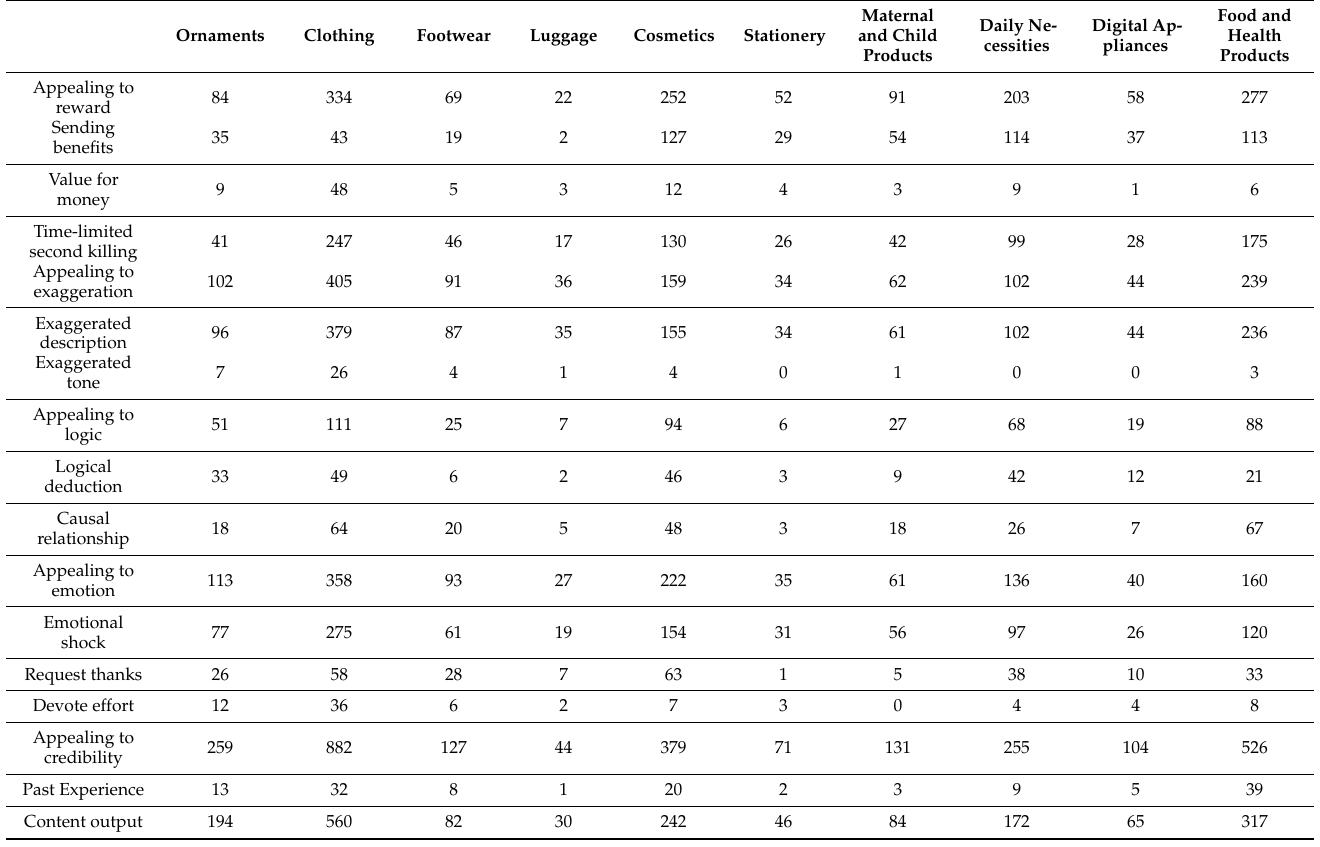
Table A1. The number of uses of language labels for various types of